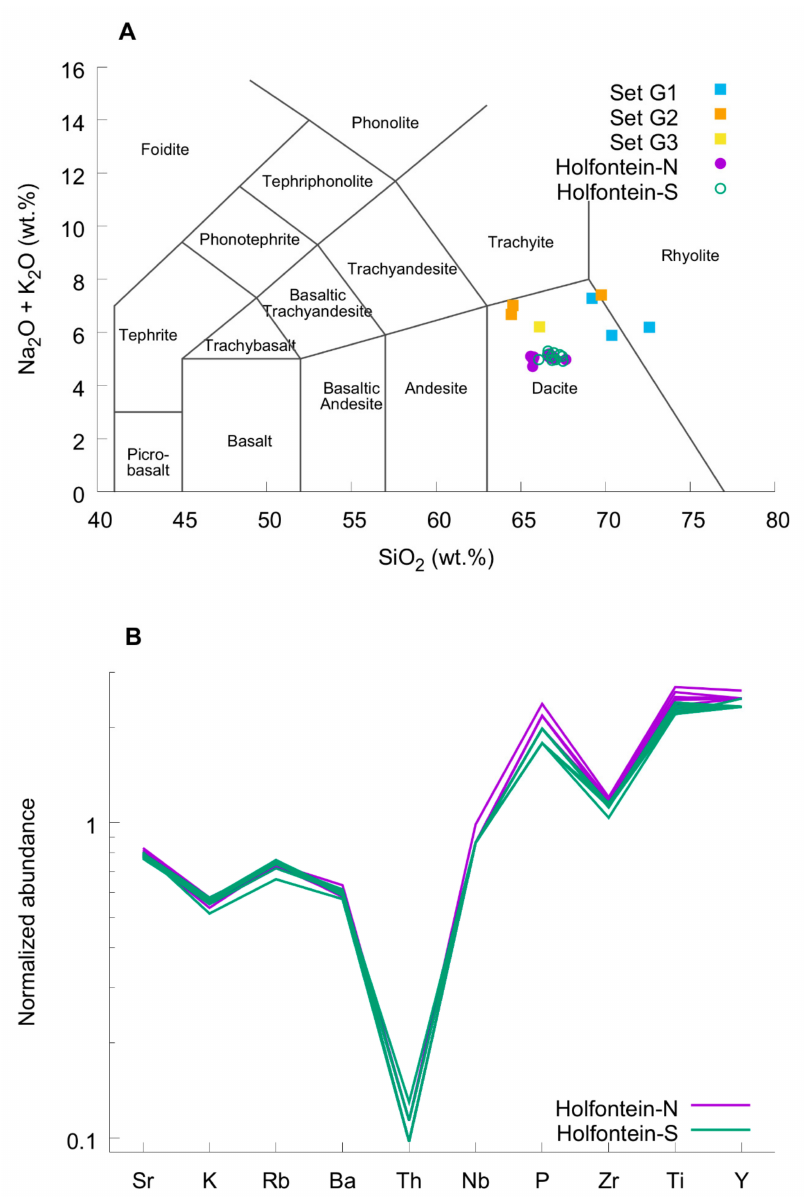
Figure 10. ( A ) Classification of the host granites and granophyre on the total alkali–silica diagram from [27]. ( B ) High-field-strength elements of HGD-N and HGD-S. The granophyre compositions were normalized to the average granite compositions measured in this